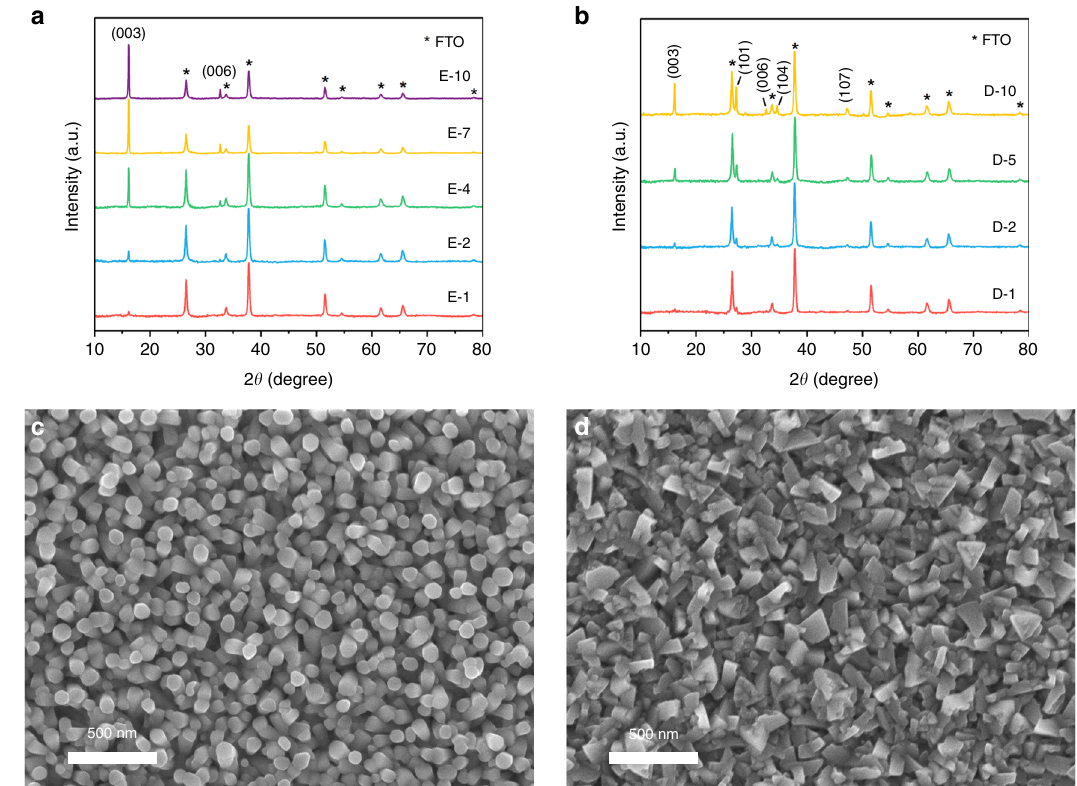
Fig. 1 XRD patterns and SEM imaging of CuSCN fi lms. a XRD patterns of CuSCN-E on FTO substrates with various electrodeposition duration. b XRD patterns of CuSCN-D on FTO substrates with various electrodeposition duration. Numbers in sample names denote the electrodeposition duration in minutes. Indexes were extracted from PDF cards of #01-077-0451 for FTO and #29-0581 for CuSCN. c Top-view image of CuSCN-E with 2 min electrodeposition. d Top-view image of CuSCN-D with 2 min electrodeposition. Scale bar: 500